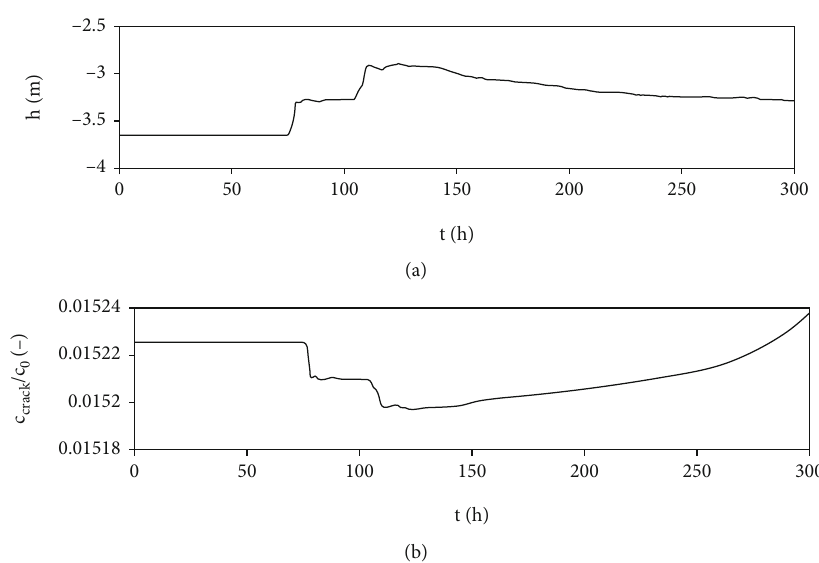
Figure 10: The groundwater table elevation data in the fi rst site [47], and simulated normalized TCE concentrations at the crack.